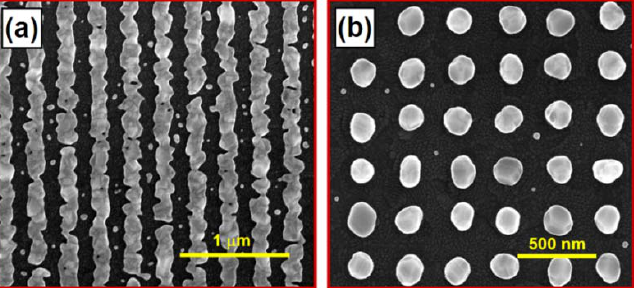
Figure 4. SEM images of the WMPC device fabricated by interference ablation, consisting of ( a ) gold nanolines and ( b ) square lattice of gold